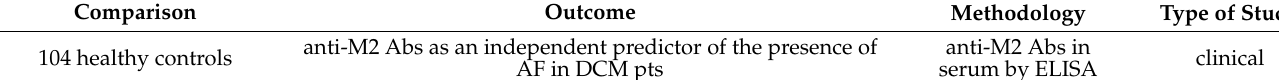
Table 2. Summary of recent research investigating only antibodies against M2-muscarinic acetylcholine receptor.